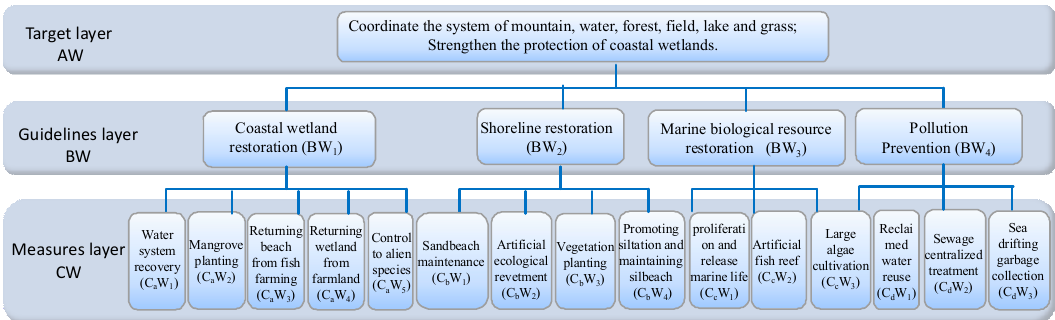
Figure 5. Hierarchical model of the reclamation projects and adjacent marine ecosystems. AW: target layer, BW: guidelines layer, CW: measures layer. layer, BW: guidelines layer, CW: measures